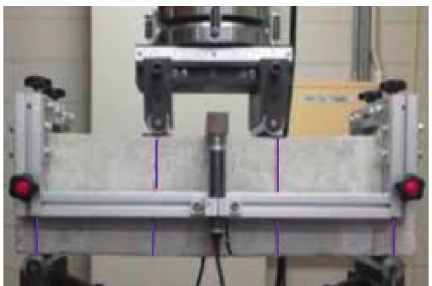
Figure 2: Test setup.